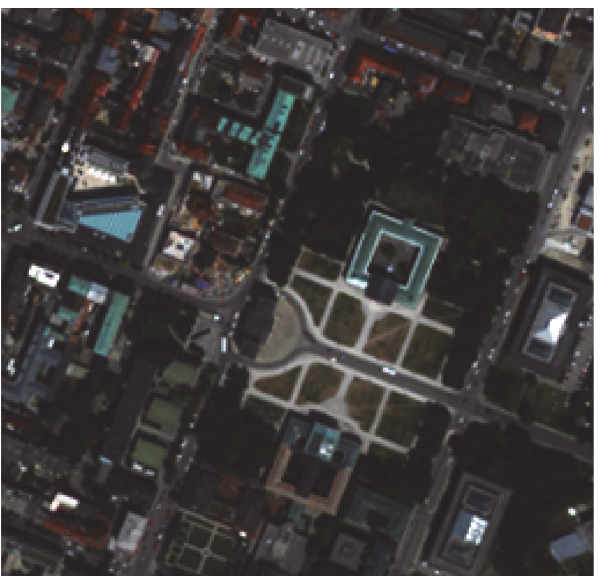
Figure 2. Bilinear interpolated bands: 5, 3, 2 of WV-2 scene.